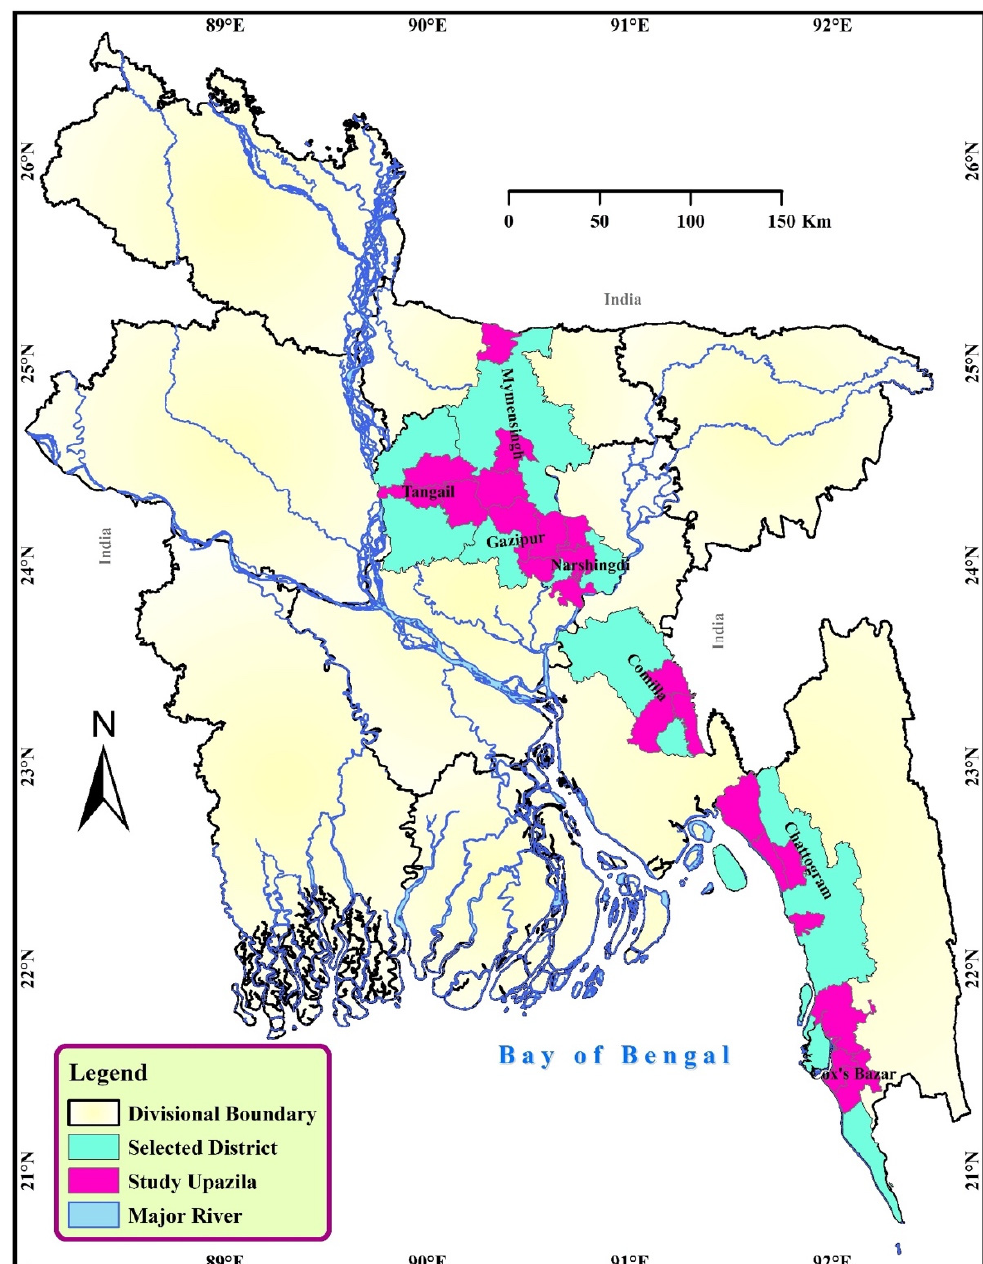
Figure 4. The map shows the study district (color: sea green) and upazilas (color: purple) of Bangladesh.